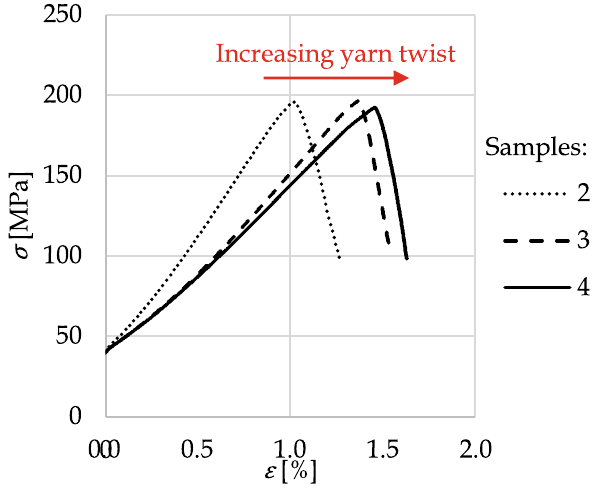
Fig. 15 Stress–strain master curves of yarn samples 2, 3 and 4